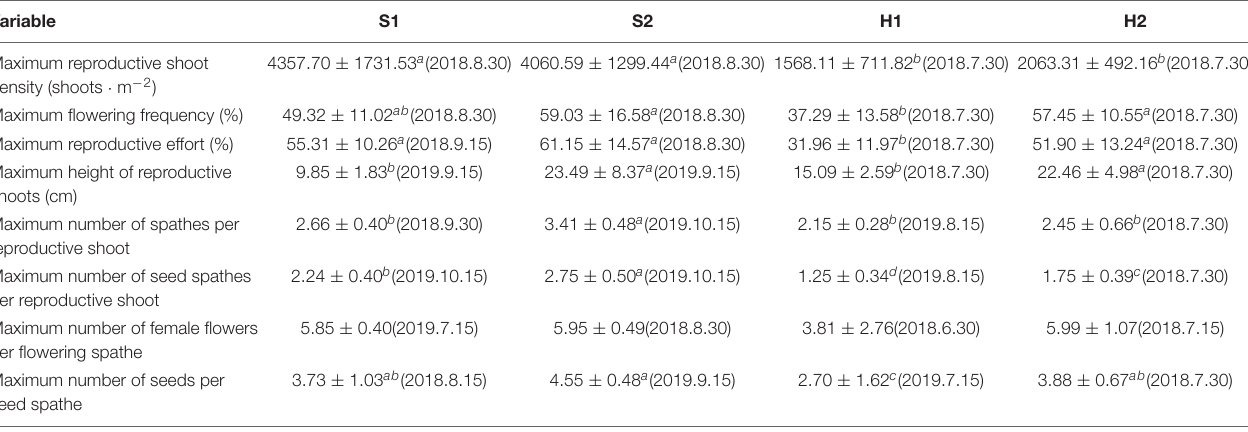
Different letters indicate significant differences at p < 0.05. Values are mean ± SD (N = 7 cores per site).